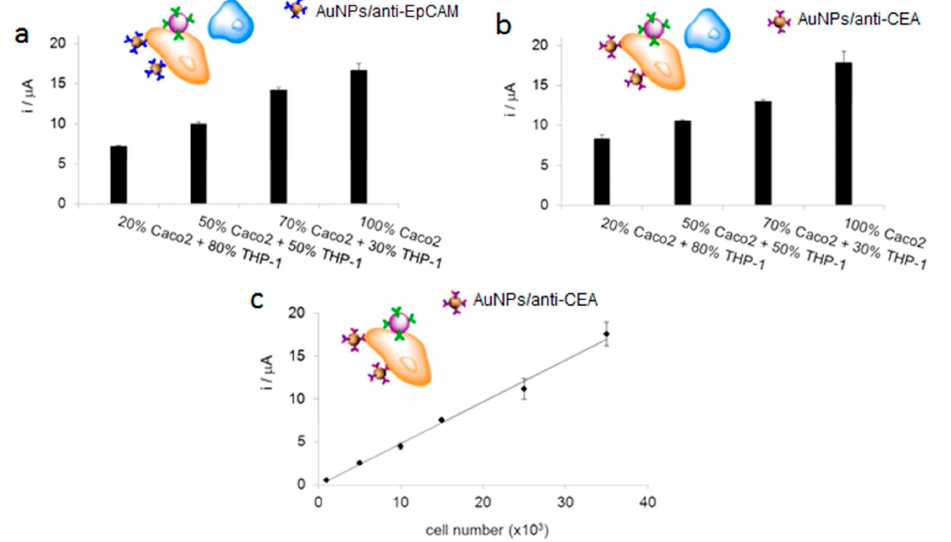
Figure 28. Electrochemical detection of Caco2 cells using MBs/antiEpCAM for selective capture. ( a , b ) Effect of the number of cells on the analytical signal for different target (Caco2) and control cells (THP-1) proportions for ( a ) simultaneous labeling with AuNPs/antiEpCAM and ( b ) simultaneous labeling with AuNPs/anti-CEA. 100% corresponds to a cell amount of 5 × 104; ( c ) Calibration plot for an increasing number of Caco2 cells (in the absence of THP-1) with simultaneous labeling with AuNPs/anti-CEA. Reprinted with permission from [153]. Copyright 2012 American Chemical